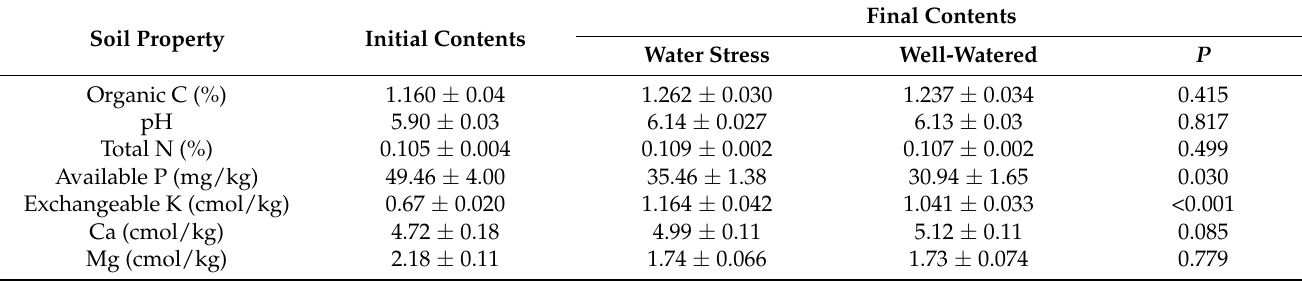
Table 2. Effect of water stress treatments on chemical properties of a sandy loam soil used to evaluate 10 cocoa varieties in a gauzehouse facility for six